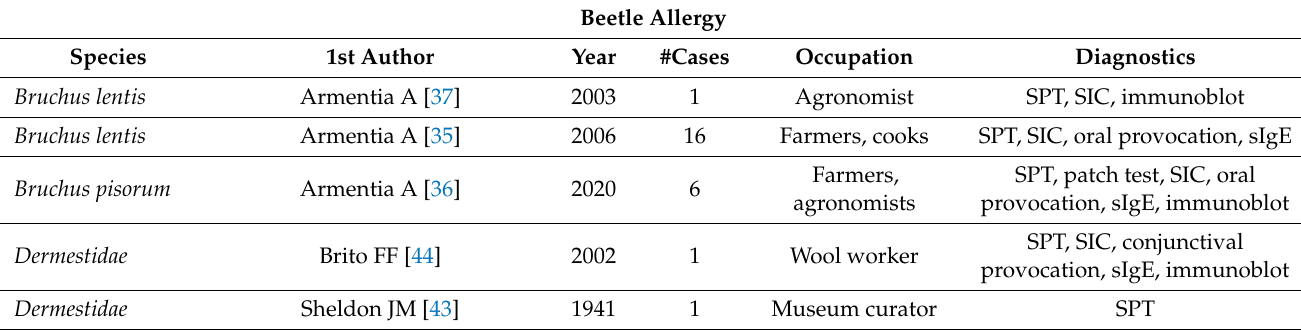
Table 2. Coleoptera